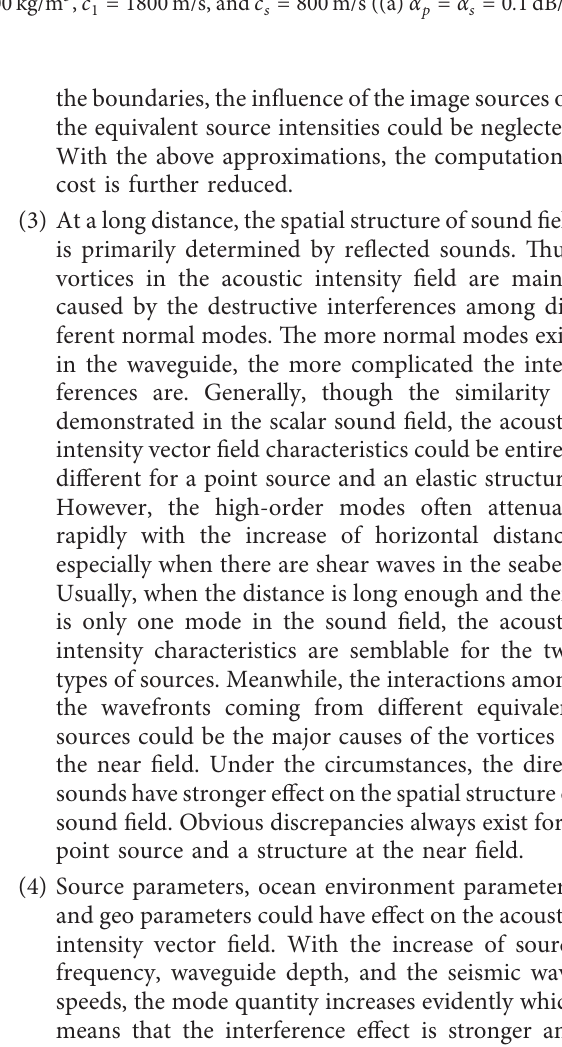
z for different wave attenuations when